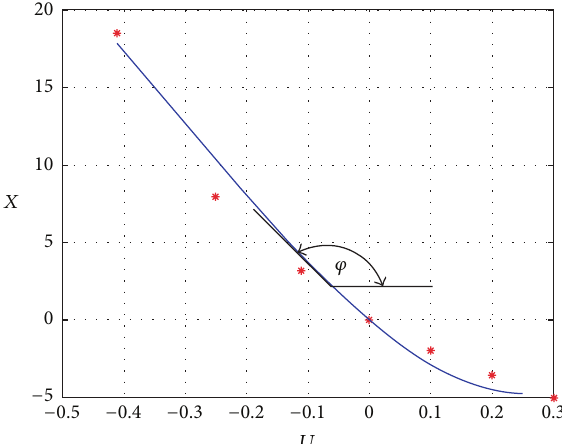
Figure 3: Estimated static nonlinearity and steady-state operation points of heat exchanger